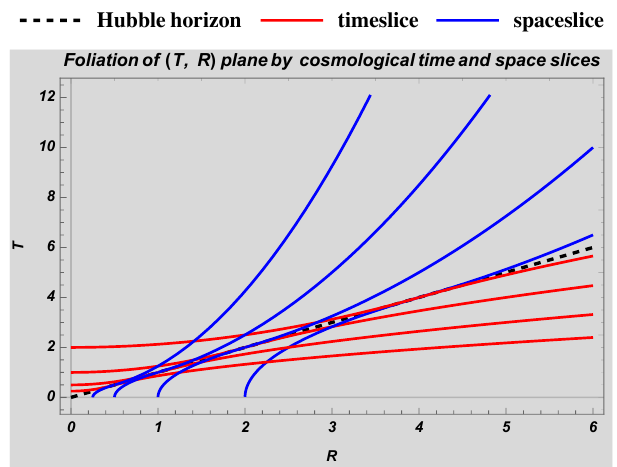
Figure 5 . A complete foliation by constant time and space slices in cosmological frame depicted in the ( T, R ) plane. The black dotted line is the comoving Hubble radius. There is no horizon for cosmological observers at the Hubble scale or anywhere in the spacetime. This figure is analogous to figure 1 but with a major difference — here the space and time slices corresponding to the cosmological observer cover the full spacetime (as they should), while the Rindler space and time slices cover only one-quarter of Minkowski spacetime (figure